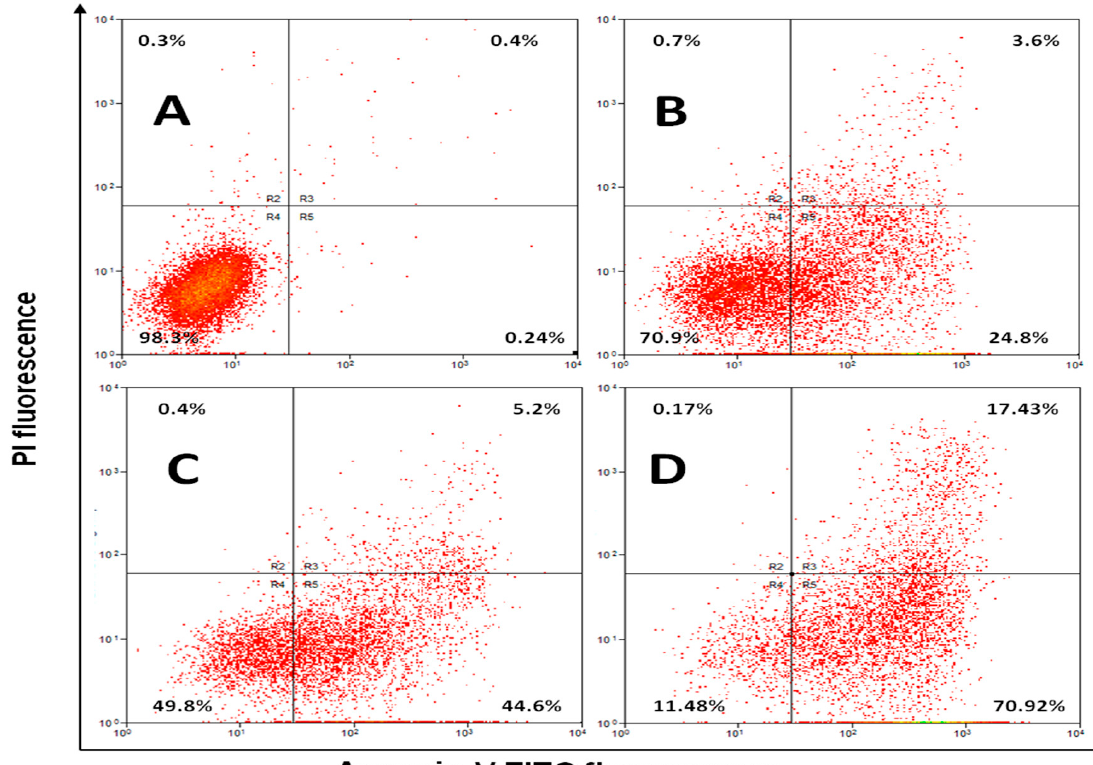
Figure 3. Annexin V-FITC and PI (propidium iodide) staining to evaluate apoptosis of Jurkat cells induced by various doses of P-Asp. ( A ) Untreated control cells; ( B ) Jurkat cells treated with 0.113 IU/mg P-Asp; ( C ) Cells treated with P-Asp at 0.56 IU/mg protein; ( D ) Cells treated with P-Asp at concentration of 2.25 IU/mg protein. In each panel the lower left quadrant shows live cells, which are negative for both PI and annexin V-FITC, the upper left quadrant shows only PI positive cells, which are necrotic. The lower right quadrant shows annexin positive cells (early apoptotic) and the upper right quadrants shows annexin and PI positive cells (late apoptosis cells).